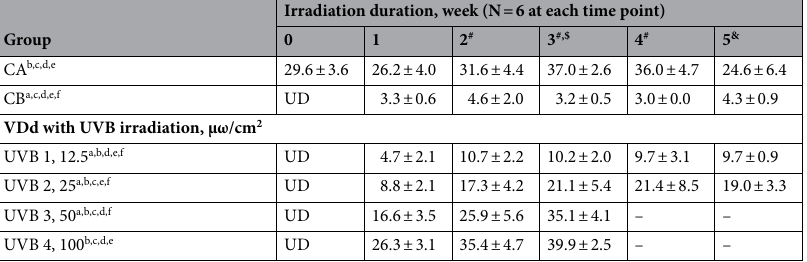
Table 1. Serum 25-hydroxyvitamin D level simulated by different doses of 308 nm UVB irradiation to VDd mice. Data represented as mean ± SD. Unit: ng/mL. The 25OHD levels lower than the detection limit of 3 ng/ mL by Elecsys cobas e411 analyzer were marked as UD. Unbalanced ANOVA with a two-way design was applied to inspect the effects of UVB dose per time and irradiation duration on 25-hydroxyvitamin D level. Differences of means between groups of UVB dose were tested by the Tukey–Kramer approach to adjust for multiple comparisons. VDd, vitamin D deficiency; UVB, ultraviolet B; CA, control A group feeding with normal diet; CB, control B group feeding with VDd diet; UD, undetectable. a P < 0.05 when compared with the mean of 25 (OH)D level in the CA group. b P < 0.05 when compared with the mean of 25 (OH)D level in the CB group. c P < 0.05 when compared with the mean of 25 (OH)D level in the UVB 1 group. d P < 0.05 when compared with the mean of 25 (OH)D level in the UVB 2 group. e P < 0.05 when compared with the mean of 25 (OH)D level in the UVB 3 group. f P < 0.05 when compared with the mean of 25 (OH)D level in the UVB 4 group. # P < 0.05 when compared with the mean of 25 (OH)D level at week 1. $ P < 0.05 when compared with the mean of 25 (OH)D level at week 2. & P < 0.05 when compared with the mean of 25 (OH)D level at week 3.